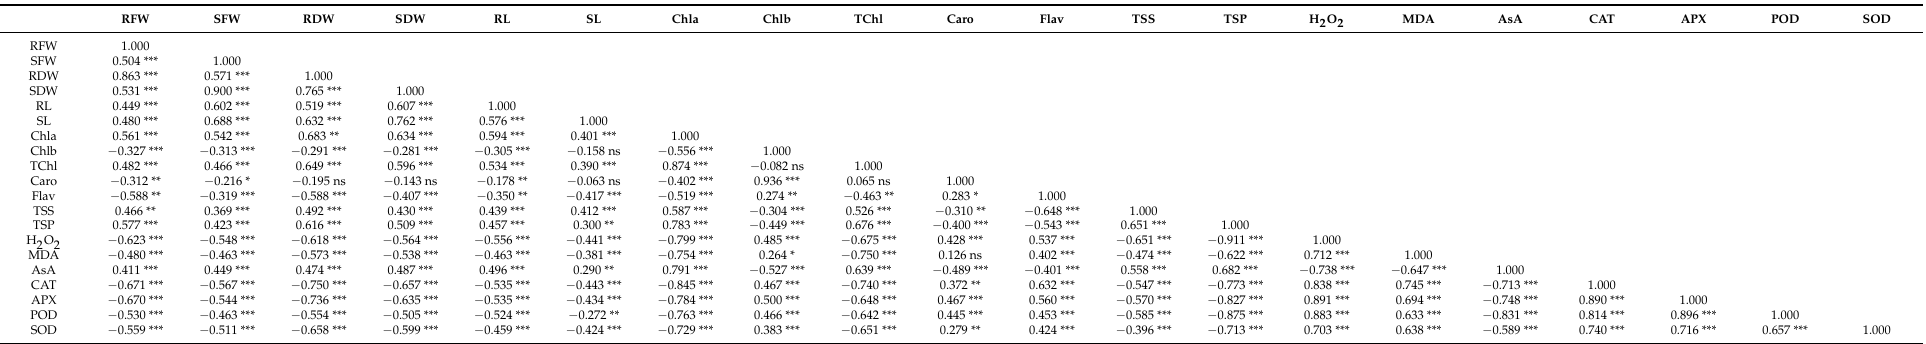
Table 4. Pearson coefficient correlation values of estimated attributes of maize ( Zea mays L.) inoculated with Bacillus spp. strains showing significance differences under drought